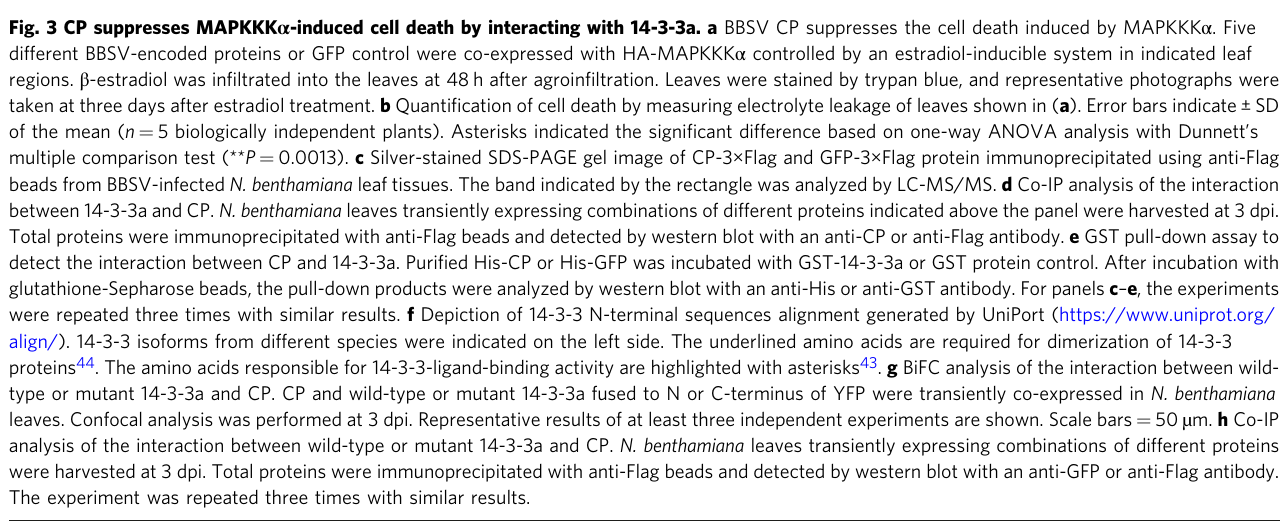
Fig. 3 CP suppresses MAPKKK α -induced cell death by interacting with 14-3-3a. a BBSV CP suppresses the cell death induced by MAPKKK α . Five different BBSV-encoded proteins or GFP control were co-expressed with HA-MAPKKK α controlled by an estradiol-inducible system in indicated leaf regions. β -estradiol was in fi ltrated into the leaves at 48 h after agroin fi ltration. Leaves were stained by trypan blue, and representative photographs were taken at three days after estradiol treatment. b Quanti fi cation of cell death by measuring electrolyte leakage of leaves shown in ( a ). Error bars indicate ± SD of the mean ( n = 5 biologically independent plants). Asterisks indicated the signi fi cant difference based on one-way ANOVA analysis with Dunnett ’ s multiple comparison test (** P = 0.0013). c Silver-stained SDS-PAGE gel image of CP-3×Flag and GFP-3×Flag protein immunoprecipitated using anti-Flag beads from BBSV-infected N. benthamiana leaf tissues. The band indicated by the rectangle was analyzed by LC-MS/MS. d Co-IP analysis of the interaction between 14-3-3a and CP. N. benthamiana leaves transiently expressing combinations of different proteins indicated above the panel were harvested at 3 dpi. Total proteins were immunoprecipitated with anti-Flag beads and detected by western blot with an anti-CP or anti-Flag antibody. e GST pull-down assay to detect the interaction between CP and 14-3-3a. Puri fi ed His-CP or His-GFP was incubated with GST-14-3-3a or GST protein control. After incubation